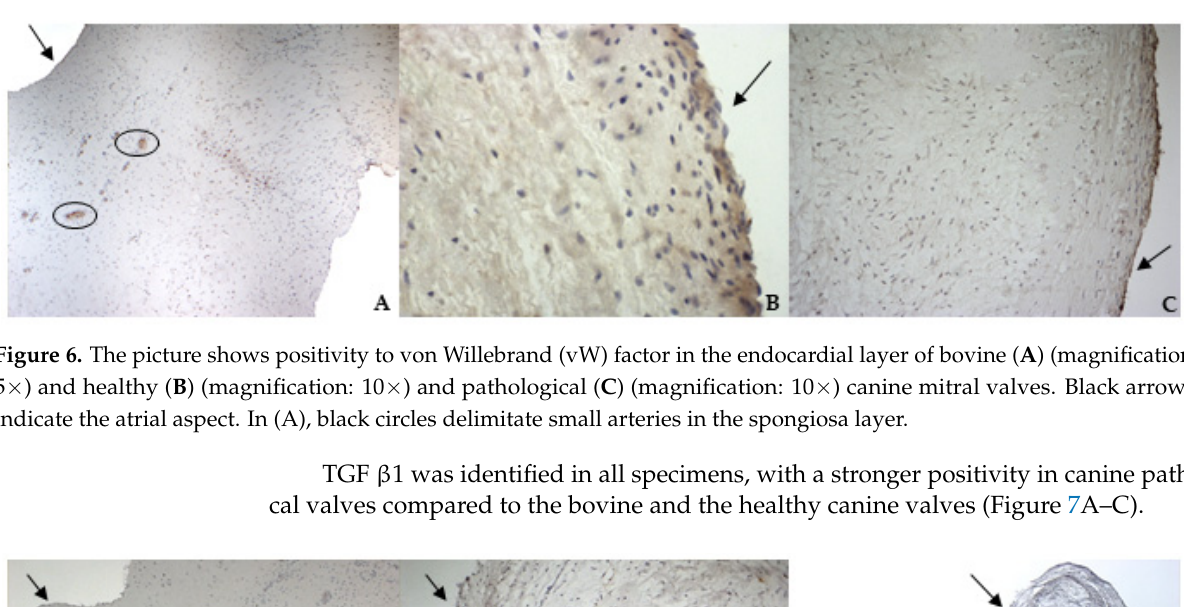
Figure 5. The picture shows positivity to smooth muscle actin (SMA) in bovine ( A ) (magnification: 5 × ) and healthy ( B ) (magnification: 10 × ) and pathological ( C ) (magnification: 5 × ) canine mitral valves. Black arrows indicate the atrial aspect, while yellow arrows indicate small arteries of the spongiosa layer. *: area of myxomatous degeneration.